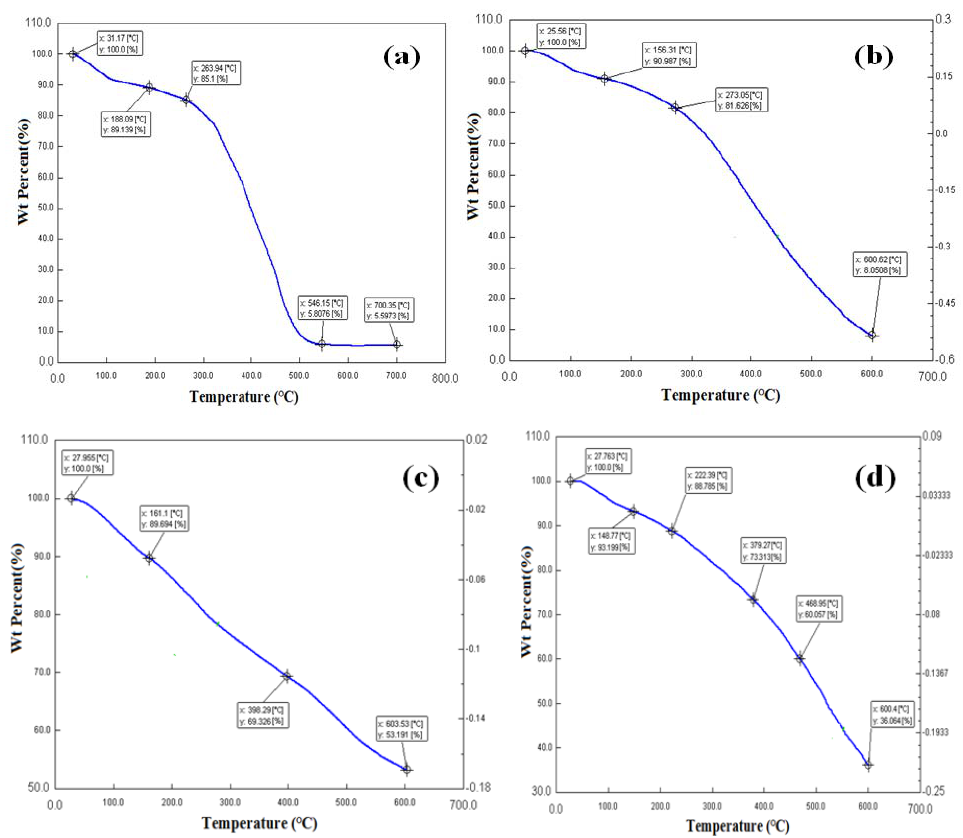
Fig. 5: TGA curve of (a) pure polypyrrole, (b) polypyrrole (with PVA), (c) polypyrrole/titanium dioxide and (d) polypyrrole/titanium dioxide (with